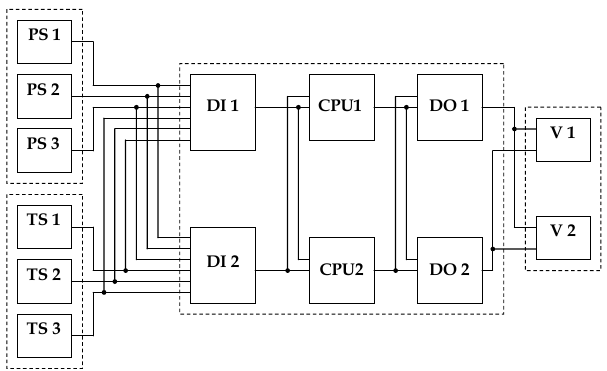
Figure 23. Structure III of E/E/PE safety-related system.